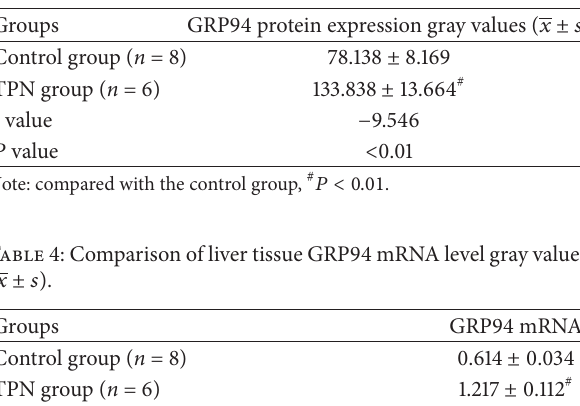
Table 3: GRP94 protein expression gray values in liver tissues ( ± s ). Groups GRP94 protein expression gray values ( 𝑥 ± 𝑠 ) Control group ( n = 8) 78.138 ± 8.169 TPN group ( n = 6) 133.838 ± 13.664 #